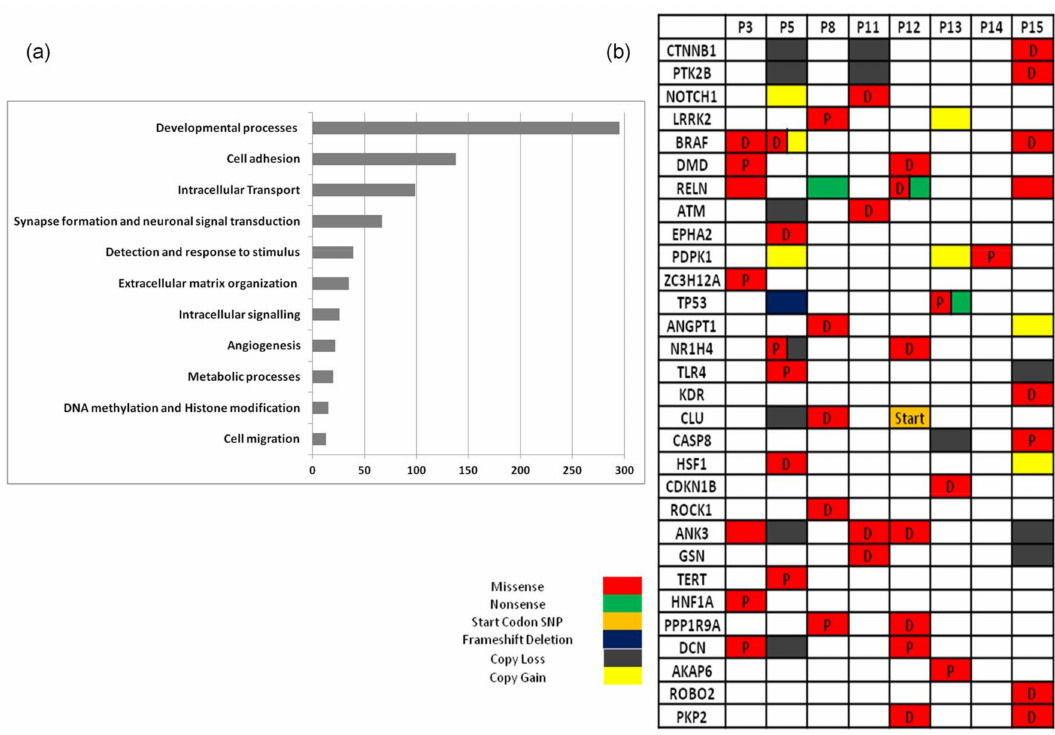
Figure 3. ( a ) Statistically significant biological processes with the corresponding number of genes found as mutated in at least one patient; ( b ) 30 top-prioritised mutated genes, D-probably damaging and P-possibly damaging mutation, as predicted by